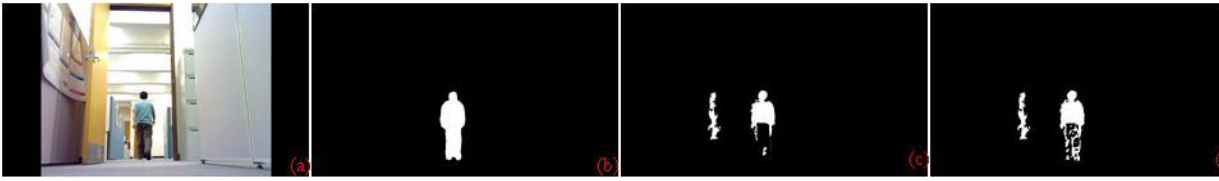
Figure 12. Simulation results for the colour similarity case. ( a ) Input ( b ) Ground truth ( c ) Method: Li et al ; ( d ) Method: Zulkifley et al